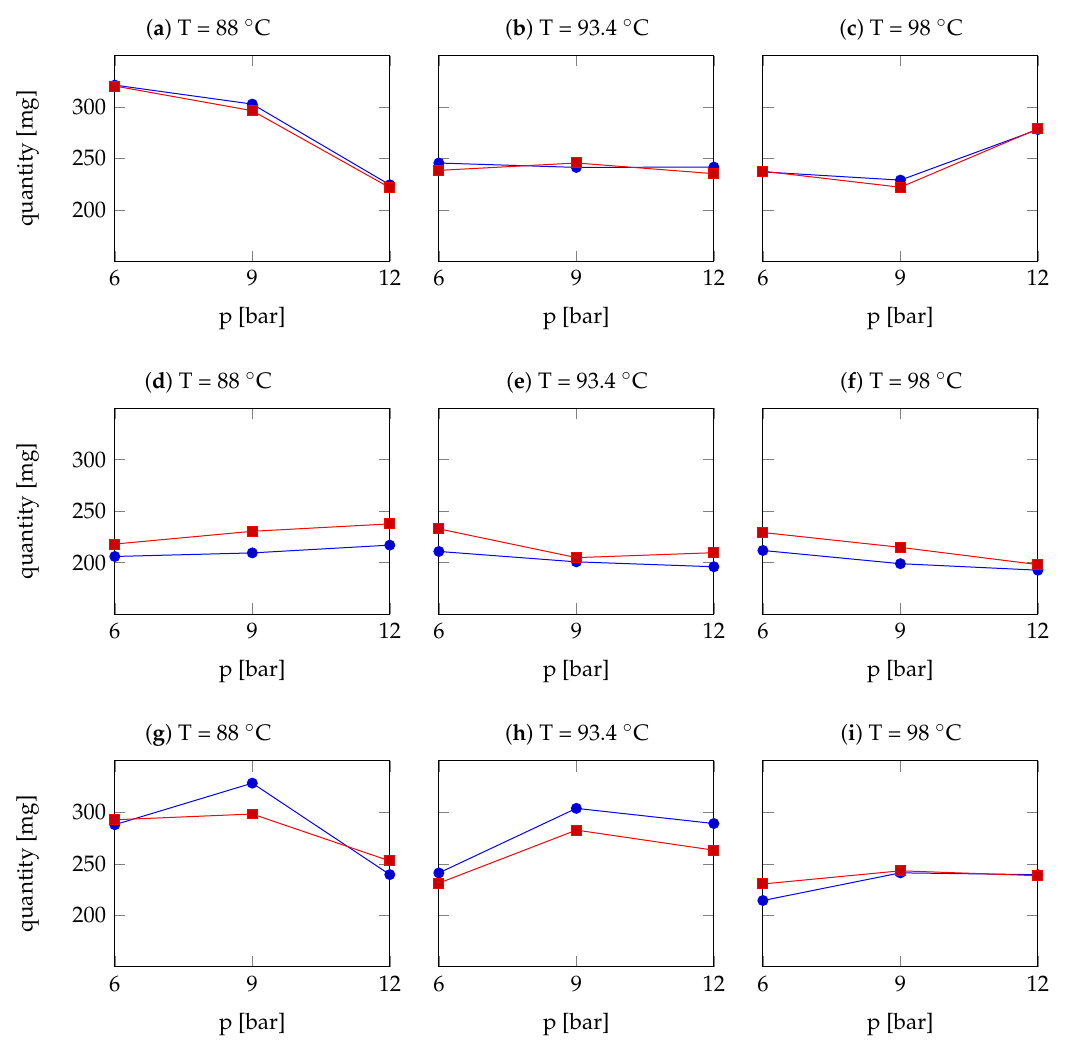
Figure 12. Comparison between the chlorogenic acids extracted through numerical simulations (blue profile with circles) and laboratory measurements (red profile with squares), with different inlet water temperatures and pressures and different grain size of Robusta coffee powder. Figures ( a – c ) show the results of optimal granulometry, Figures ( d – f ) of coarse granulometry and Figures ( g – i ) of fine granulometry.